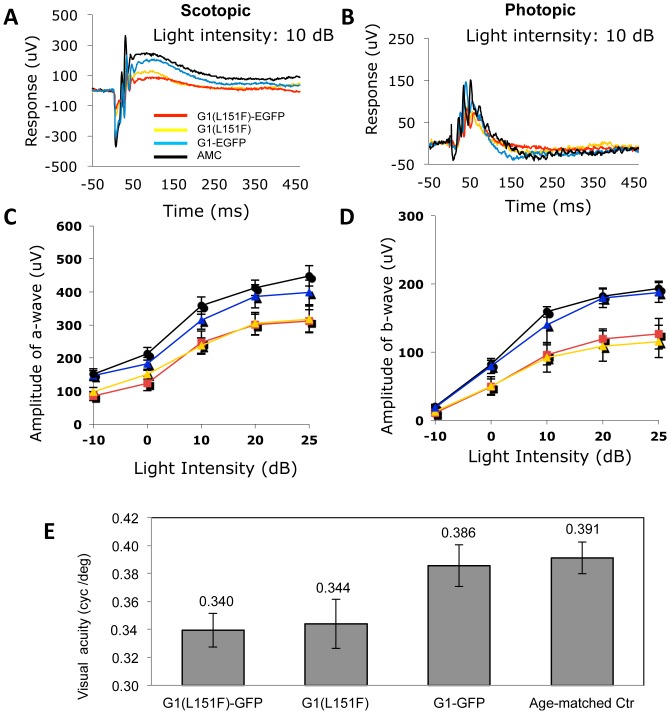
Retinal function of three GCAP1 transgenic mouse lines evaluated by ERG and Optomotry.Scotopic (A) and photopic (B) ERG analysis at age 12 months (n = 5 mice per genotype). Average a-wave amplitudes of the scotopic responses (C) and b-wave amplitudes of the photopic responses (D) as a function light intensity. Error bars are standard deviations. E. Visual acuities of GCAP1 transgenic mice versus age-matched controls (n = 4) were tested by Optomotry at 12 months of age. Error bars are standard deviations, *p<0.05.